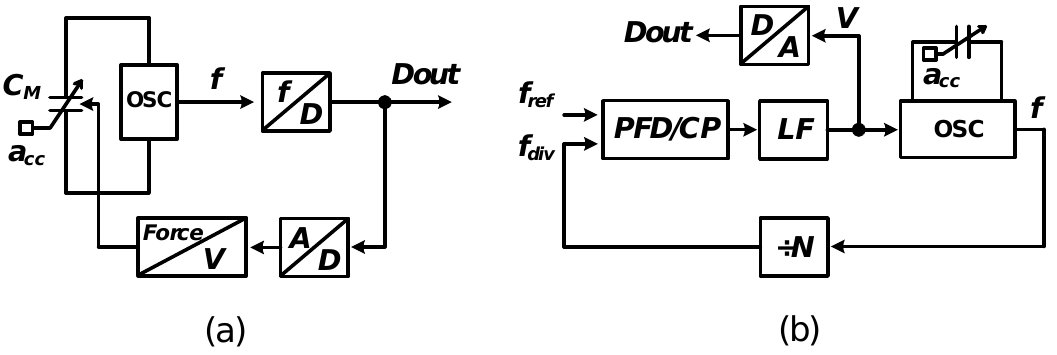
Figure 2. Closed-loop operations of sensor-controlled oscillators: ( a ) force balance; ( b )